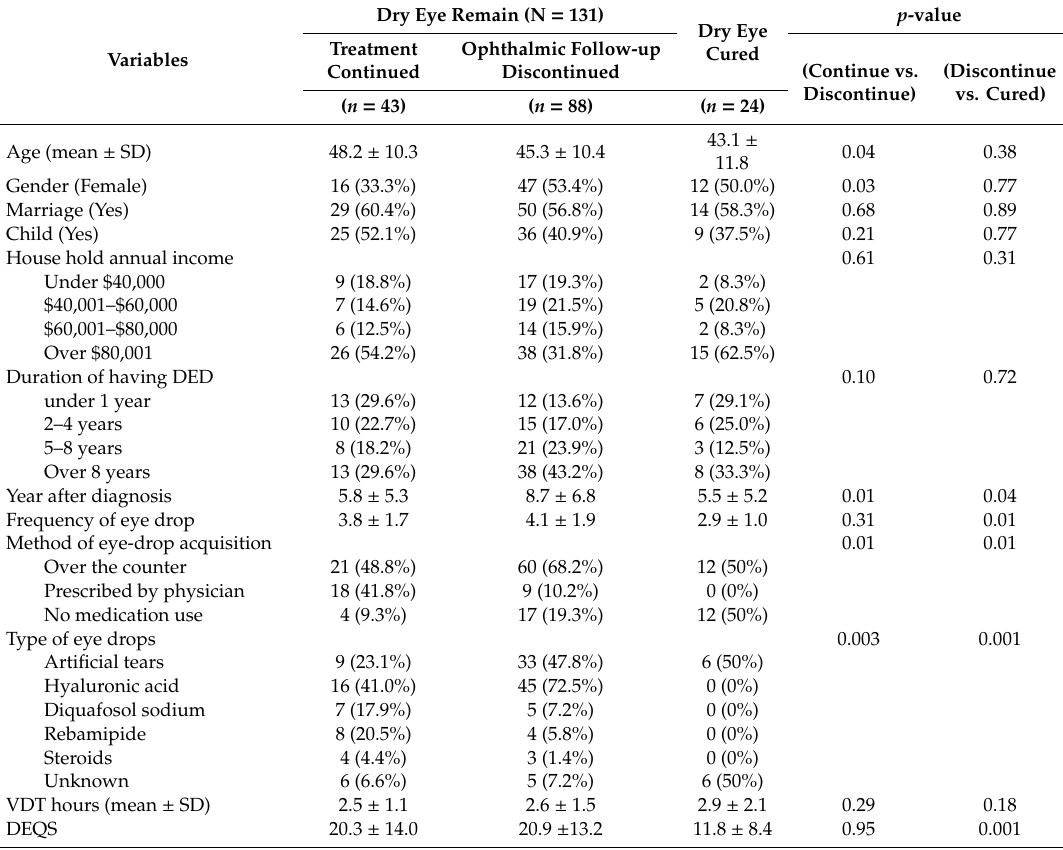
Table 1. Characteristics of subjects according to the dry eye condition.